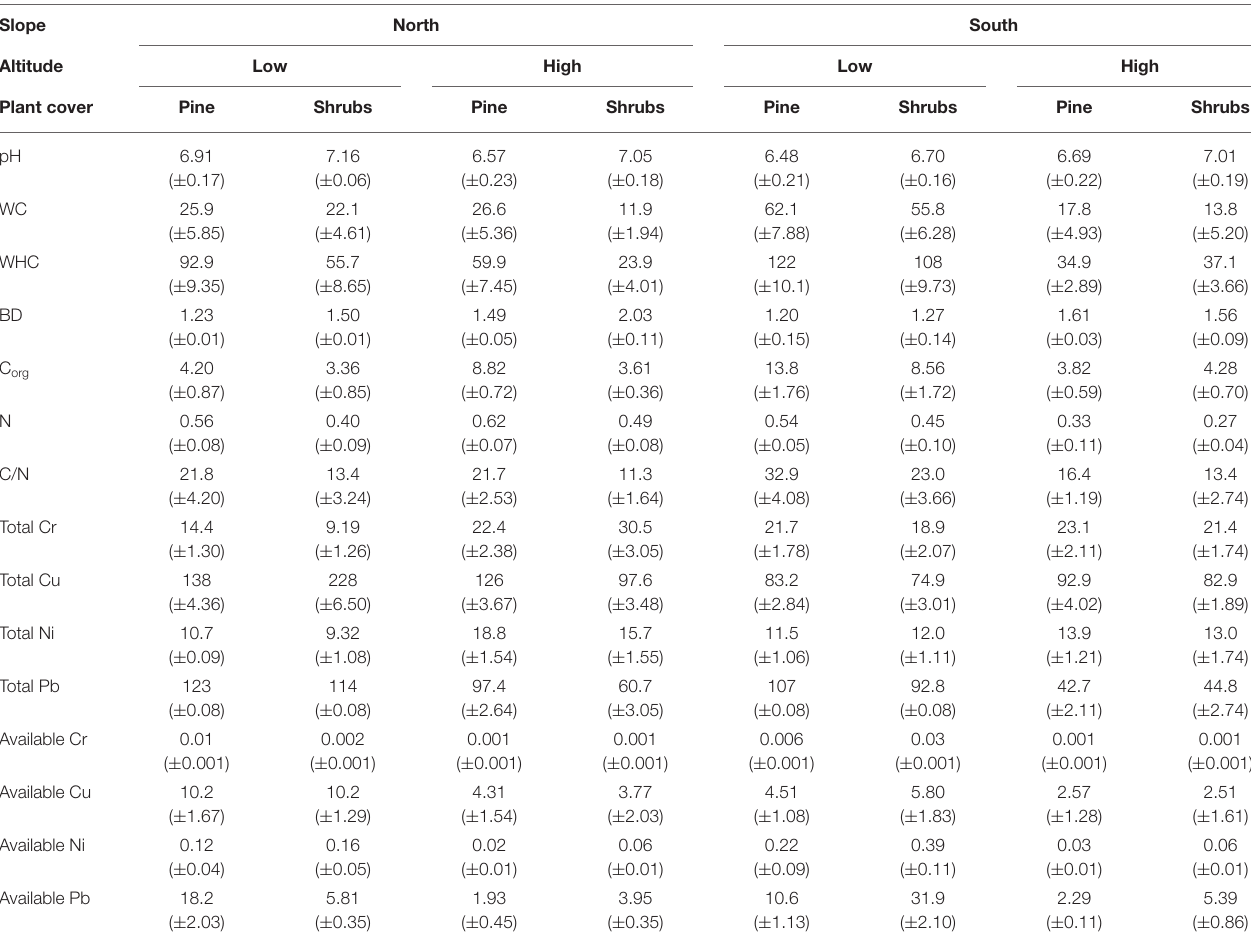
TABLE 1 | Mean values ( ± s.e.) of pH, water content (WC, expressed as % d.w.), water holding capacity (WHC, expressed as % d.w.), and bulk density (BD, expressed as mg cm − 3 ). Slope North South Altitude Low High Low High Plant cover Pine Shrubs Pine Shrubs Pine Shrubs Pine